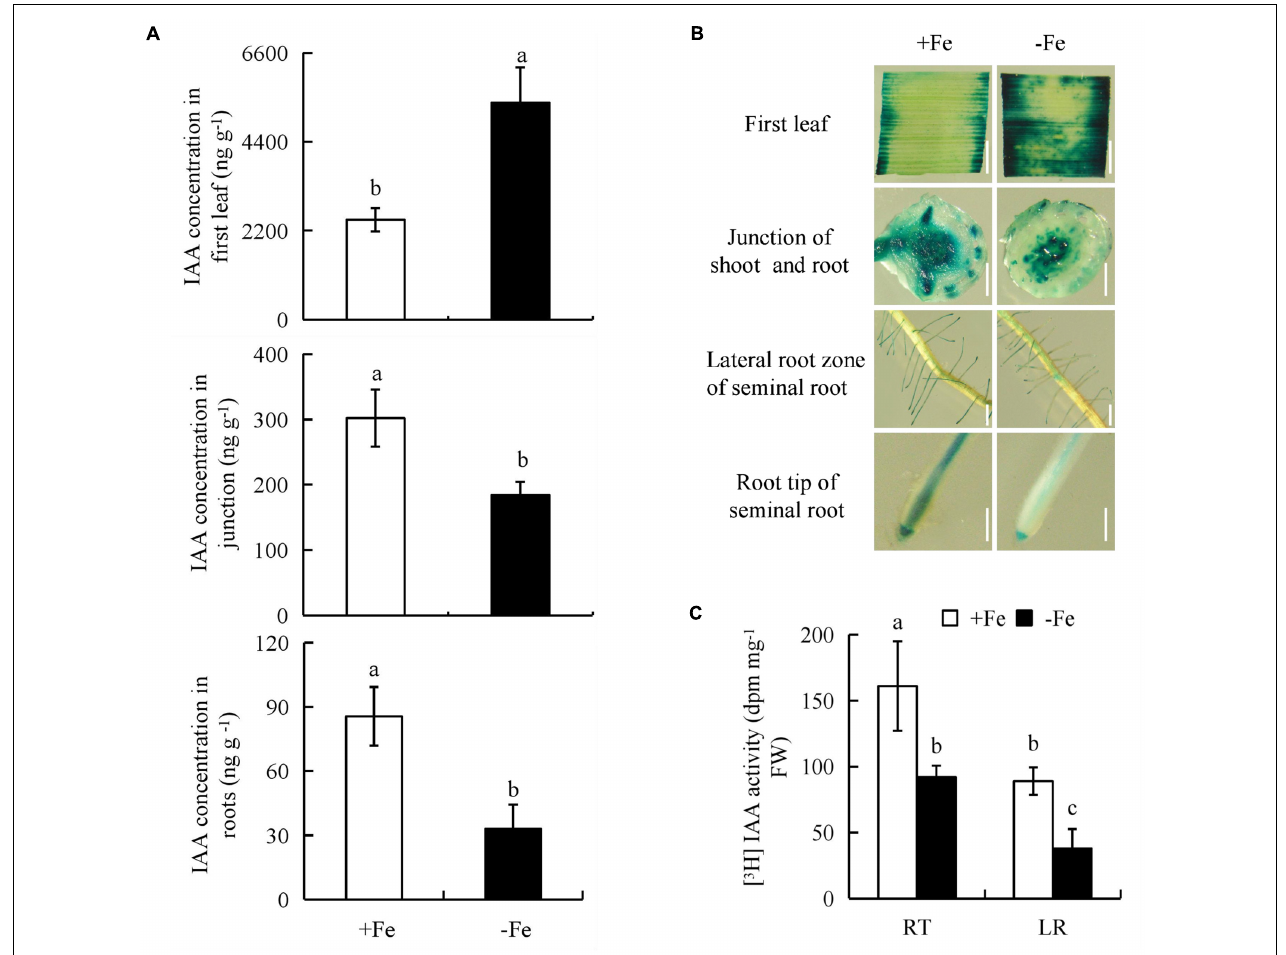
FIGURE 2 | Indole-3-acetic acid (IAA) concentration and histochemical localization of DR5::GUS activity and [ 3 H]IAA transport in rice seedlings. Rice seedlings were grown in hydroponic media containing − Fe (0 µ M) and +Fe (20 µ M) for 14 days. (A) IAA concentration in first leaf, the junction of root and shoot, and roots. (B) DR5::GUS , a specific reporter that contains seven repeats of a highly active synthetic auxin response element and can reflect the in vivo auxin level. Plants were stained for GUS activity in the first leaf for 24 h and in other regions for 2 h at 37 ◦ C. Bar = 1 mm. (C) Root tip [The root tip (RT) of seminal root]; LR zone. Data are means ± SE and bars with different letters indicate significant difference at P < 0.05 tested with